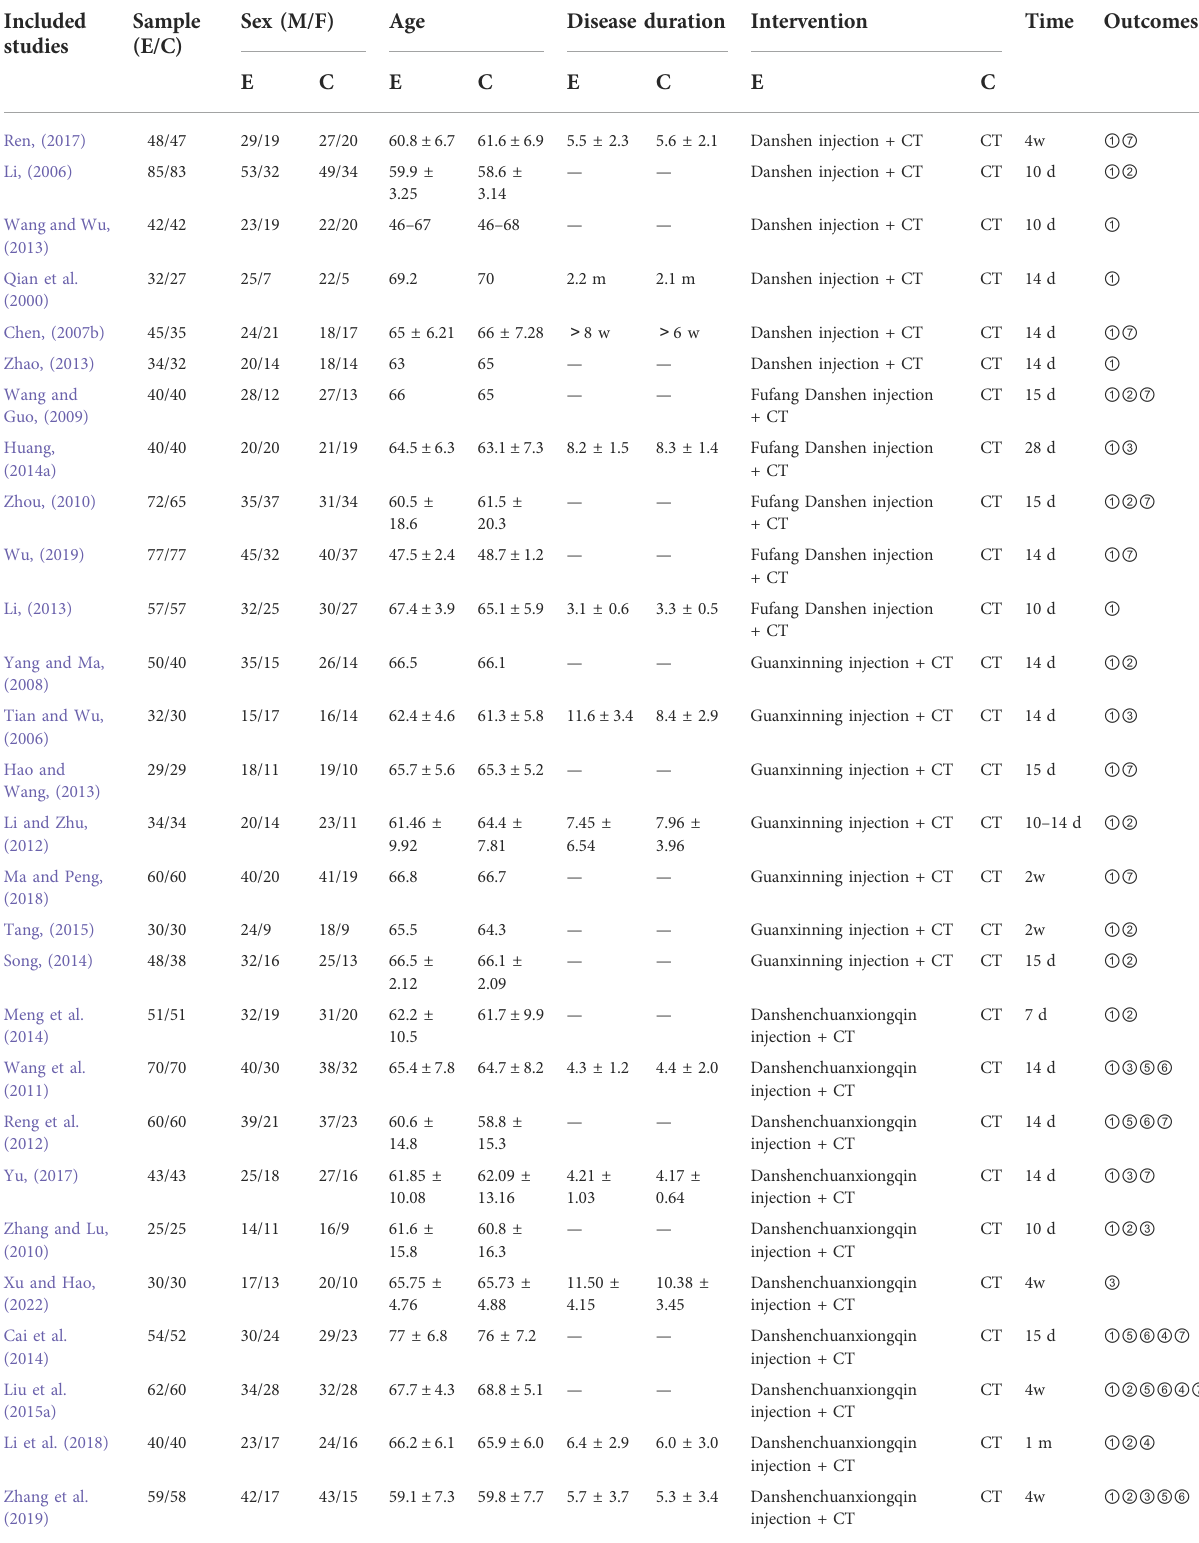
TABLE 1 Characteristics of included